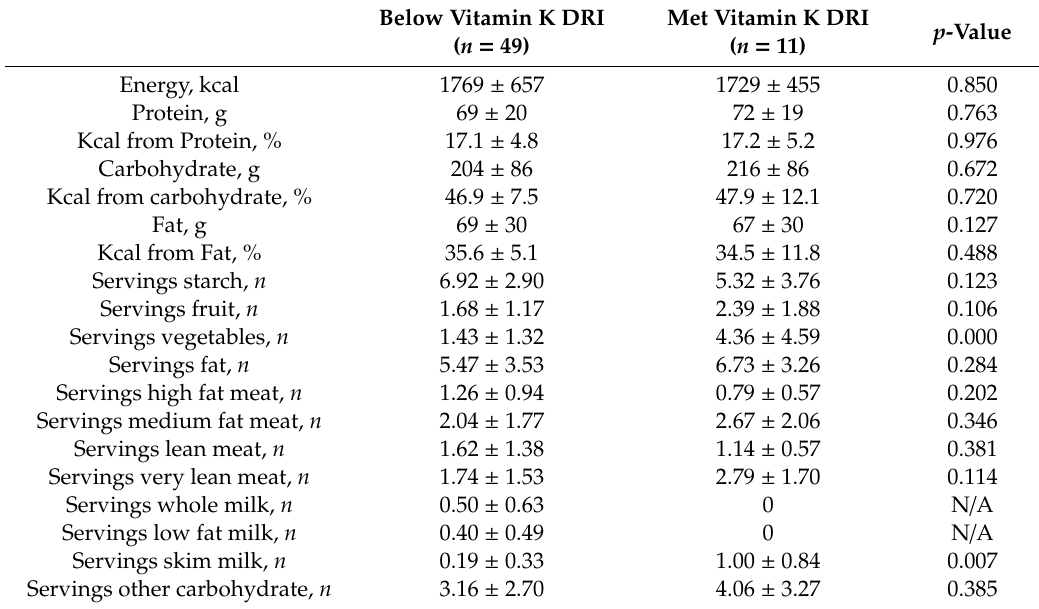
Table 3. Macronutrient and food group